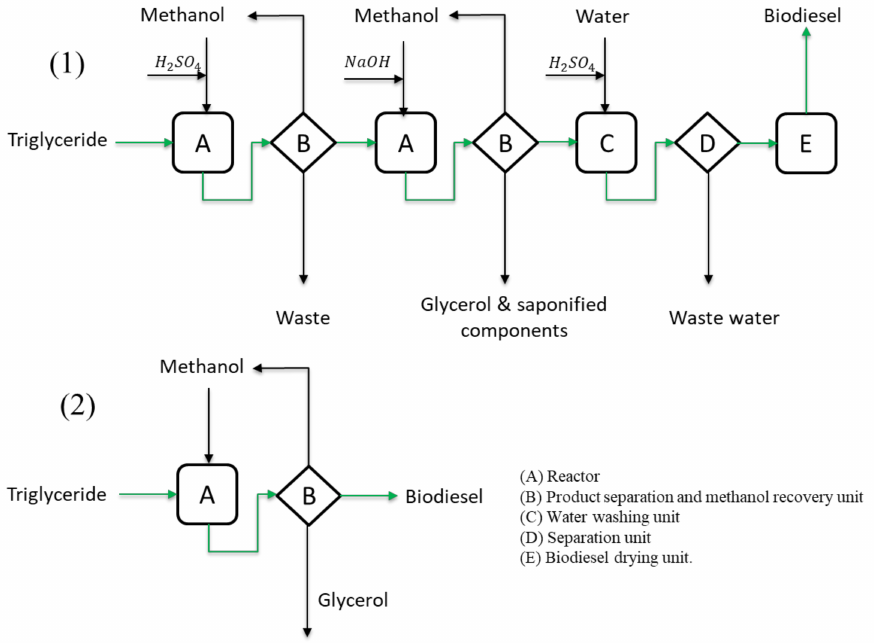
Figure 4. The catalyzed process (1) and the super-critical methanol process (2). Oil and alcohol reactions are known to proceed by three consecutive reaction steps (Equations (1)–(3)), in which the diglyceride formation (Equation (1)) is the rate-limiting step. At low conversion values, the system has mass transfer limitations due to